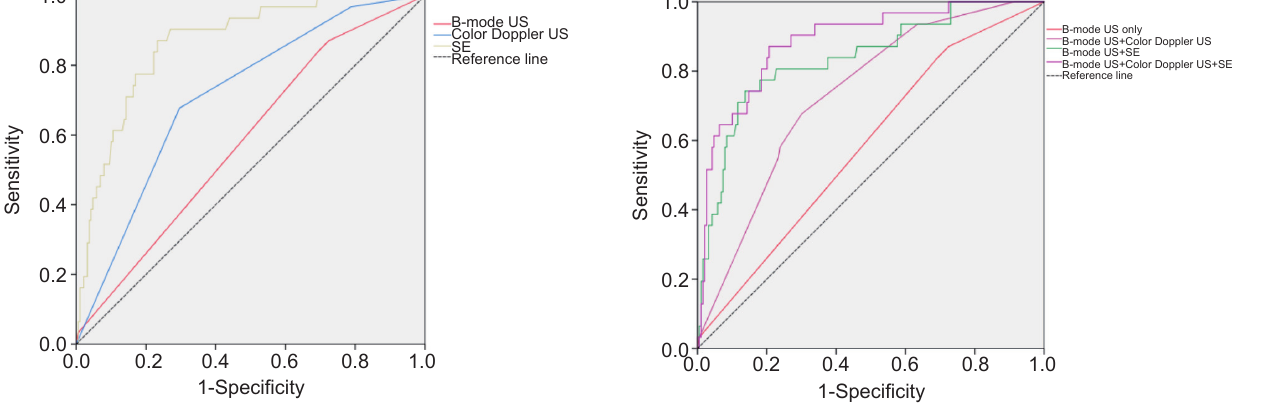
Figure 3 Receiver operating characteristic curves for B-mode US and three sets of combined tests. The area under the curve (AUC) for B-mode US was 0.584 (95% CI: 0.481, 0.687); AUC increased to 0.836 (95% CI: 0.755, 0.917) ( P < 0.001) in addition to strain elastography to B-mode US, 0.733 (95% CI: 0.647, 0.819) ( P = 0.03) in addition to color Doppler US to B-mode US, and 0.886 (95%